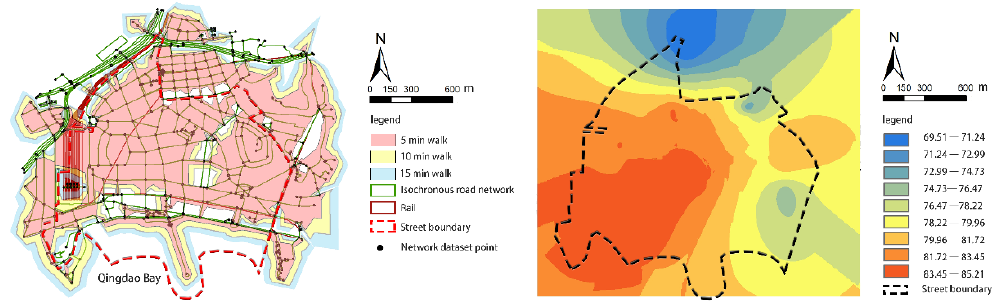
Figure 3. Walking coverage and general walking index.